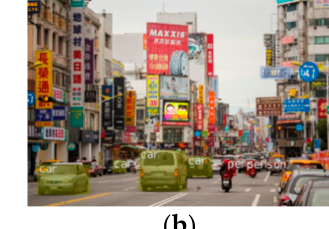
Figure 10. Object recognition results: ( a ) first set (target object: person); ( b ) second set (target object: traffic light). Figure 11. Results of preliminary identification: ( a ) first set; ( b ) second set.